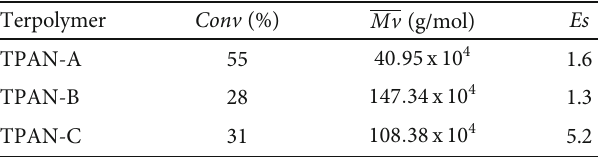
Table 9: Properties of developed precursor fi